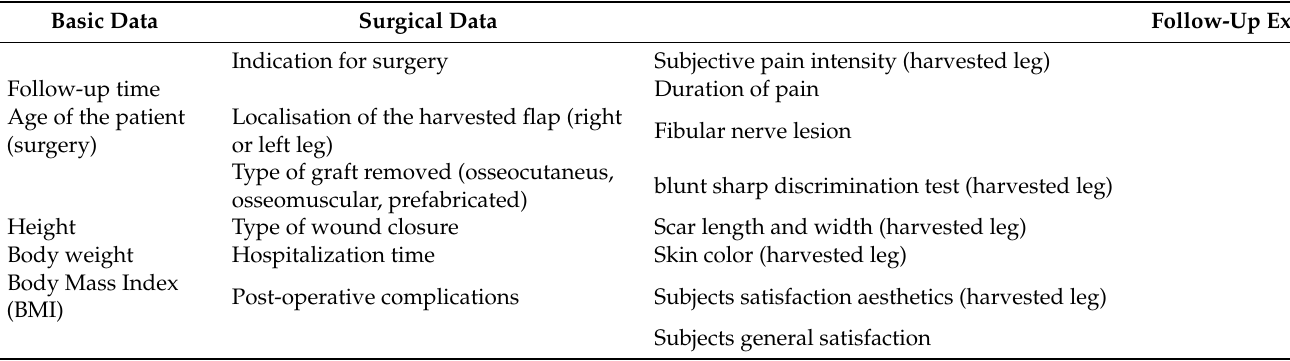
Table 5. The collected study parameters divided into basic, surgical, and follow-up